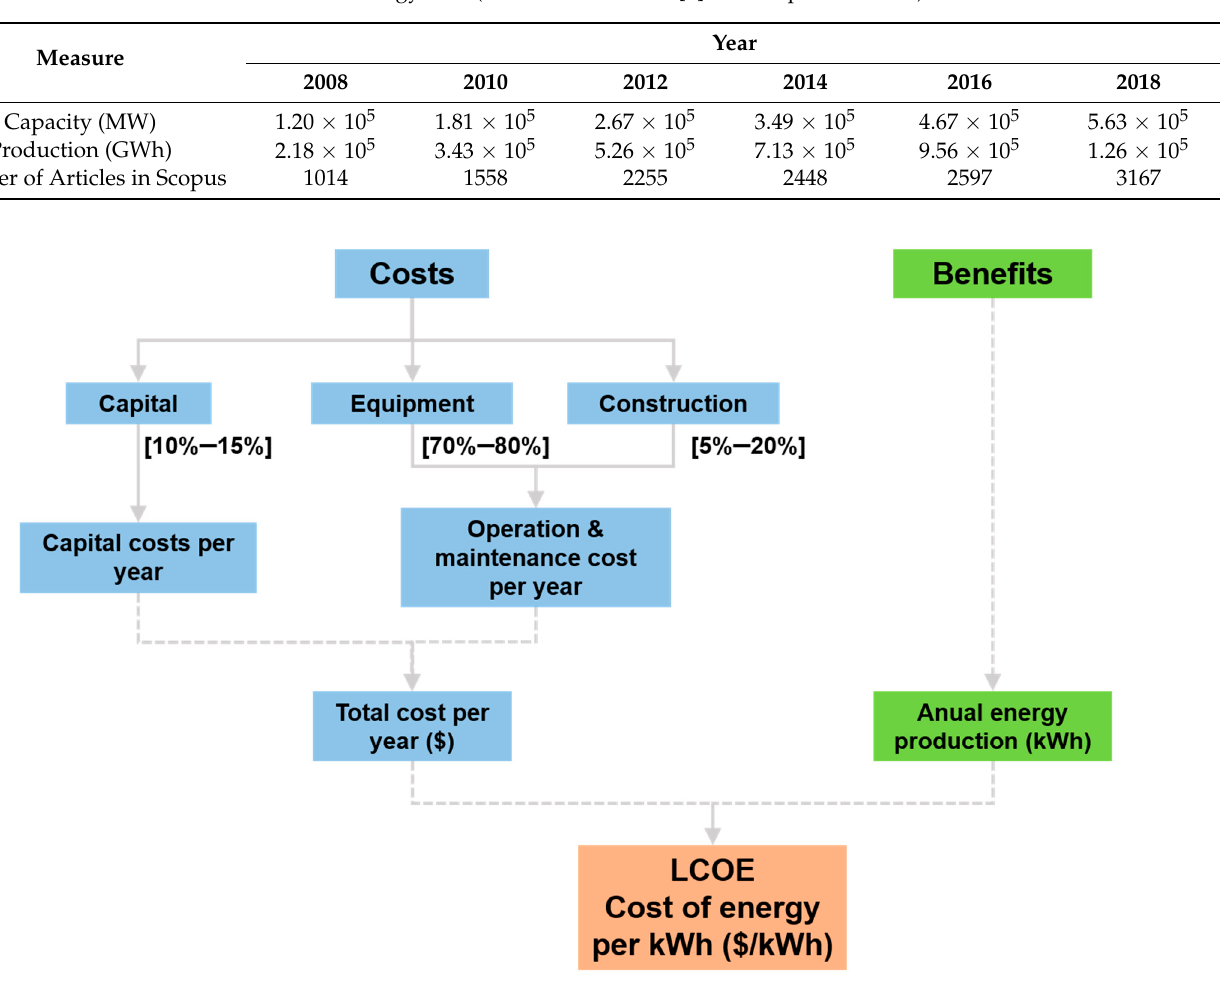
Table 1. Wind energy data (data collected from [ 1 ] and Scopus database).